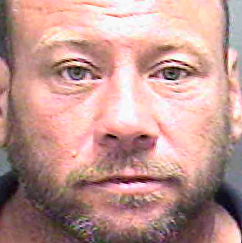
Figure 11. An example photo from the CIA database. Figure 12. An example photo from the Morph database. Table 16. Recognition results of the CIA photo. Table 17. Recognition results of the Morph photo.